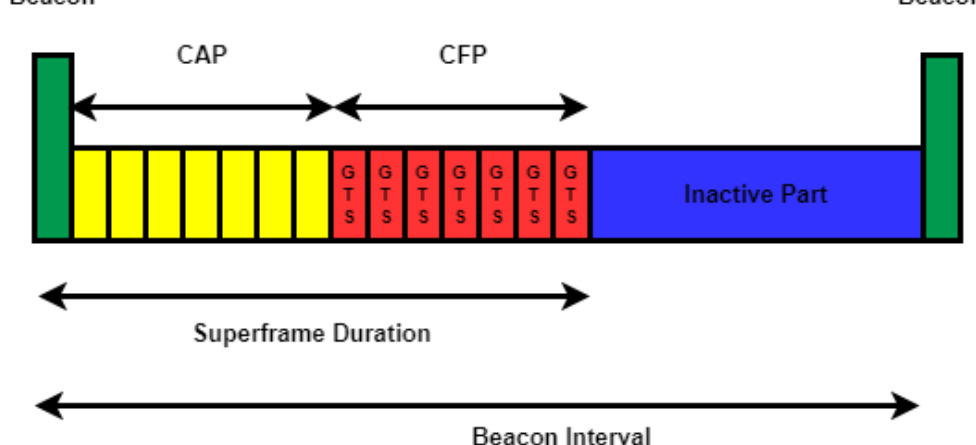
Figure 2. Superframe Structure for Beacon Enabled mode in the IEEE 802.15.4 - An